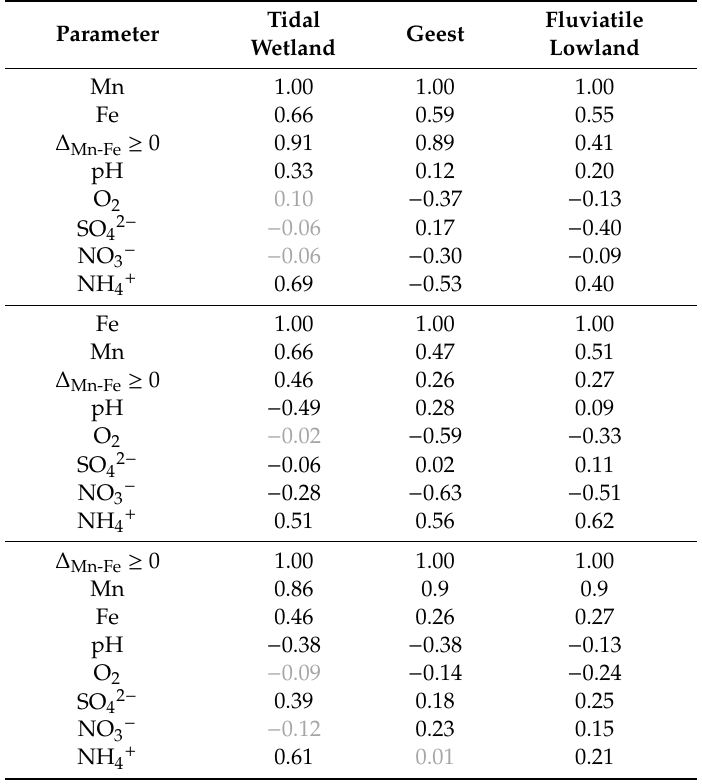
Table 2. Spearman’s Rank Correlation for Mn, Fe and ∆ Mn-Fe > 0 with additional hydrogeochemical parameters for the most recent analyses from each well, grouped by hydrogeological unit 1 . Tidal Geest Parameter Wetland